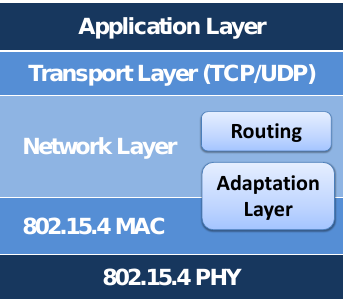
Figure 6: The IP stack with the adapta tion layer Fragmen tation is the basic mechanism provided by the adapta tion layer [39]. When the data packets cannot fi the 802.15.4 MAC frame payload size, the packets are fragmen ted into multiple link-layer frames. It simply provides the ability to encode a datagr am, but not incl udes the end- to-end recov ery of the lost fragmen ts.